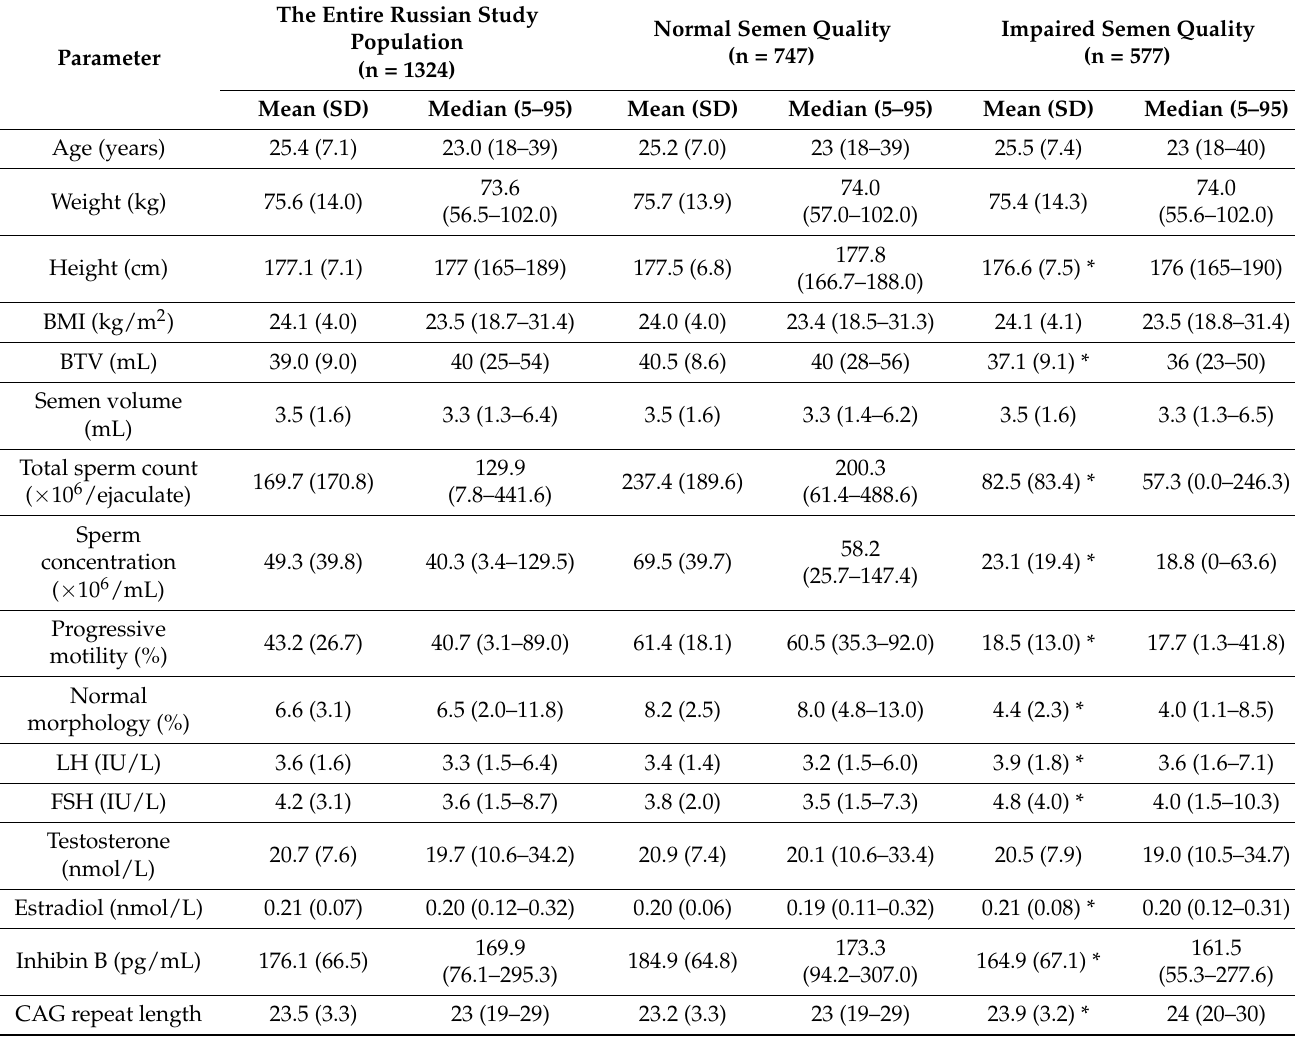
Table 1. Anthropometric, semen and hormonal characteristics of the entire Russian study population and subgroups with normal and impaired semen